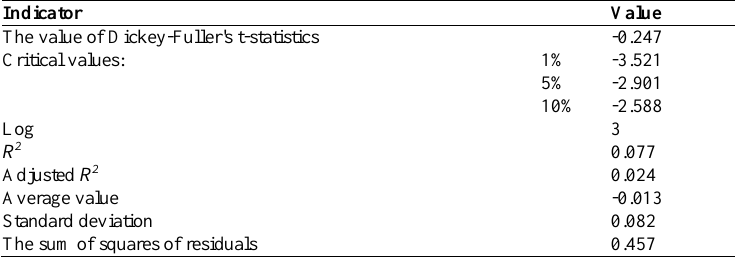
Table 1. Estimations of the non-stationarity of the series ln (D) by the DF test Indicator